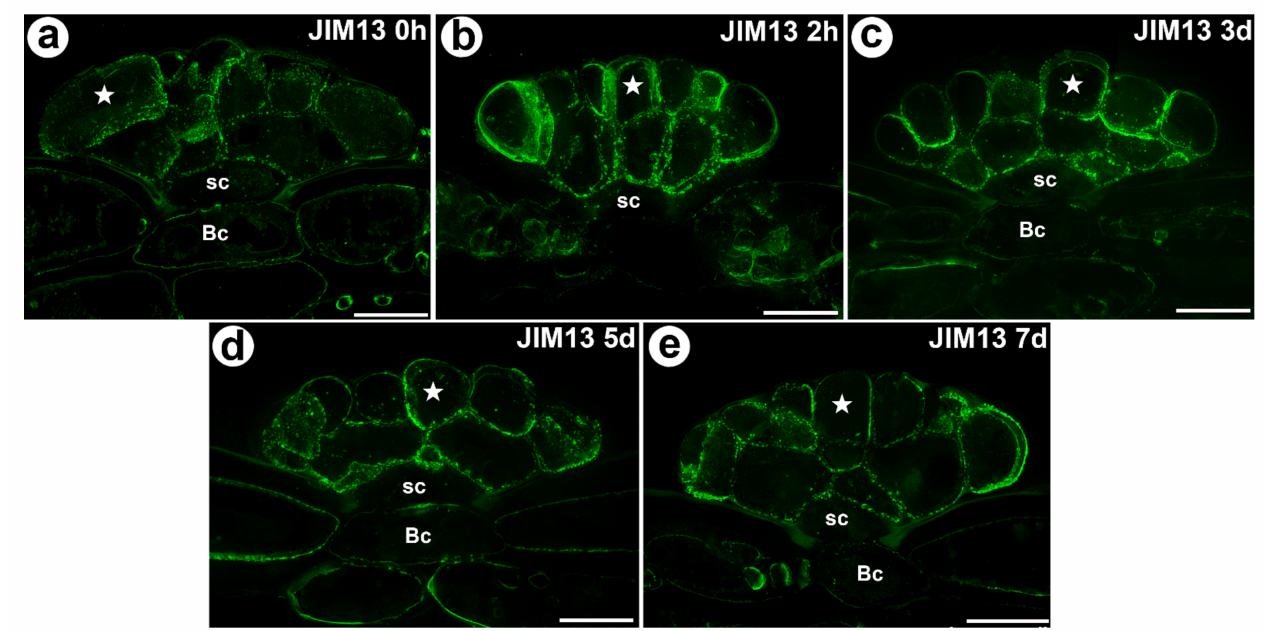
Figure 4. The arabinogalactan proteins (labeled with JIM13) that were detected in a D. muscipula trap. ( a ) Immunolabeling of AGP with JIM13 that were detected in the gland from an unfed trap: secretory cell (star), stem cell (sc), bar 20 µ m. ( b ) Immunolabeling of AGP with JIM13 that were detected in a gland two hours after feeding: secretory cell (star), stem cell (sc), bar 20 µ m. ( c ) The arabinogalactan proteins (labeled with JIM13) that were detected in a gland three days after feeding: secretory cell (star), stem cell (sc), basal cell (Bc), bar 20 µ m. ( d ) Immunolabeling of AGP with JIM13 that were detected in a gland five days after feeding: secretory cell (star), stem cell (sc), basal cell (Bc), bar 20 µ m. ( e ) Immunolabeling of AGP with JIM13 that were detected in a gland seven days after feeding: secretory cell (star), stem cell (sc), basal cell (Bc), bar 20 µ m. All photos maximum are projections from